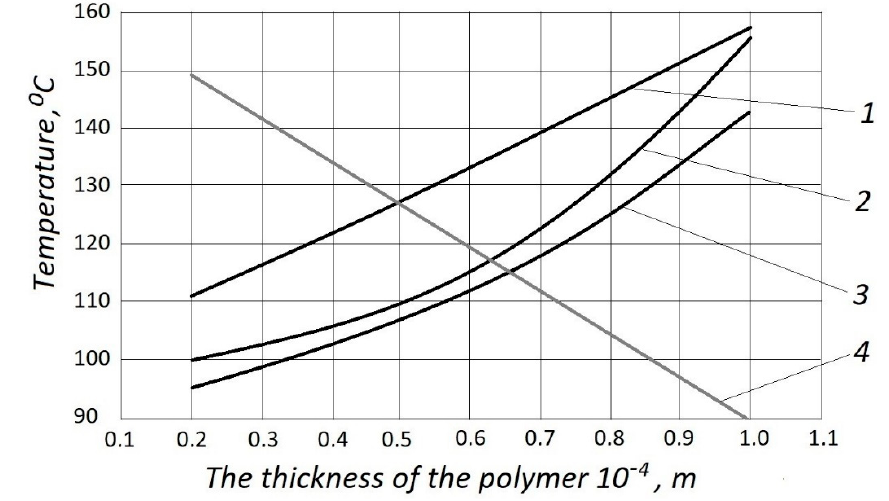
Figure 8. The relations between polymer coating thickness and temperature.